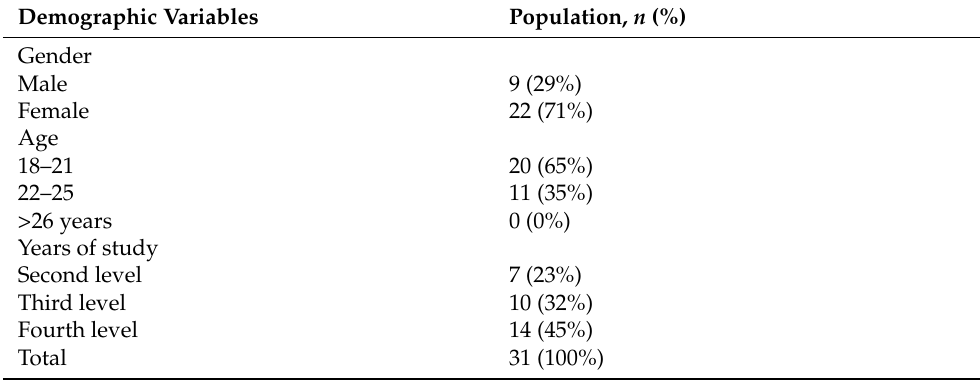
Table 2. Demographic profile of learner nurses.